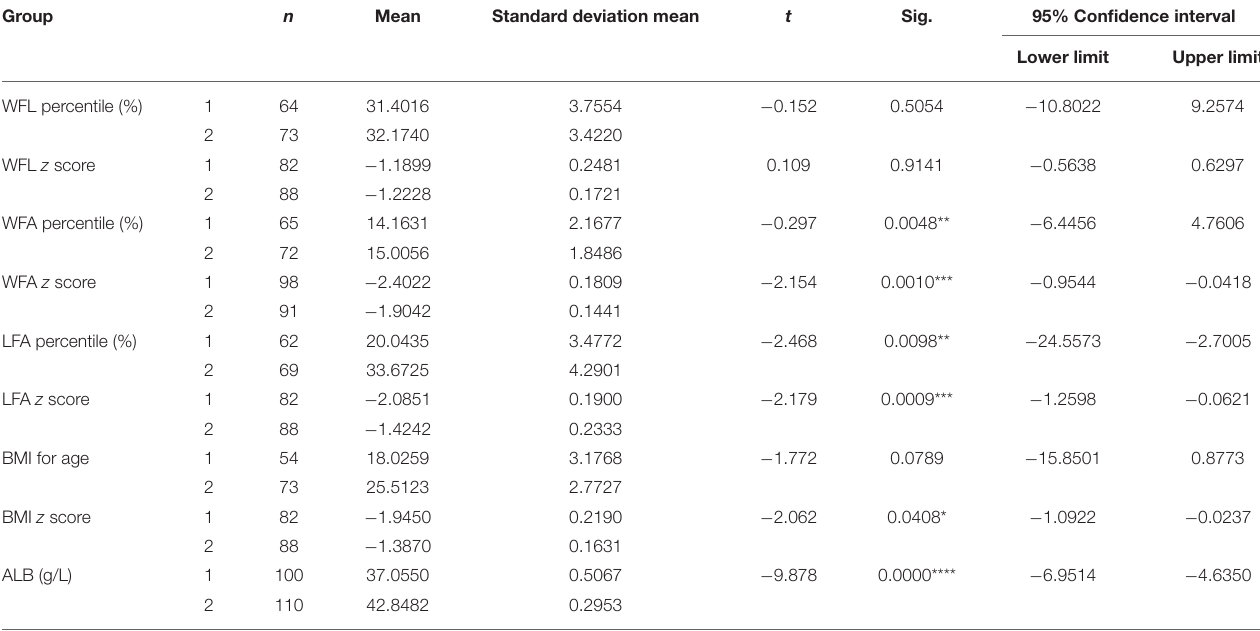
TABLE 2 | Comparative statistics of independent sample t test about physical indicators before and after BMDO. Group n Mean Standard deviation mean t Sig. 95% Confidence interval